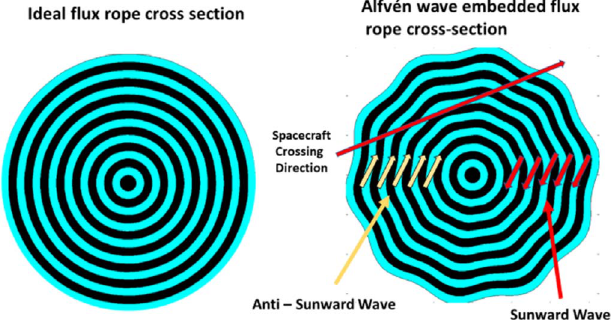
Figure 6. Cartoon depiction of the generation of a SAW: the fi rst image shows the ideal fl ux rope cross section and the second manifests the spacecraft crossing a cross section of the fl ux